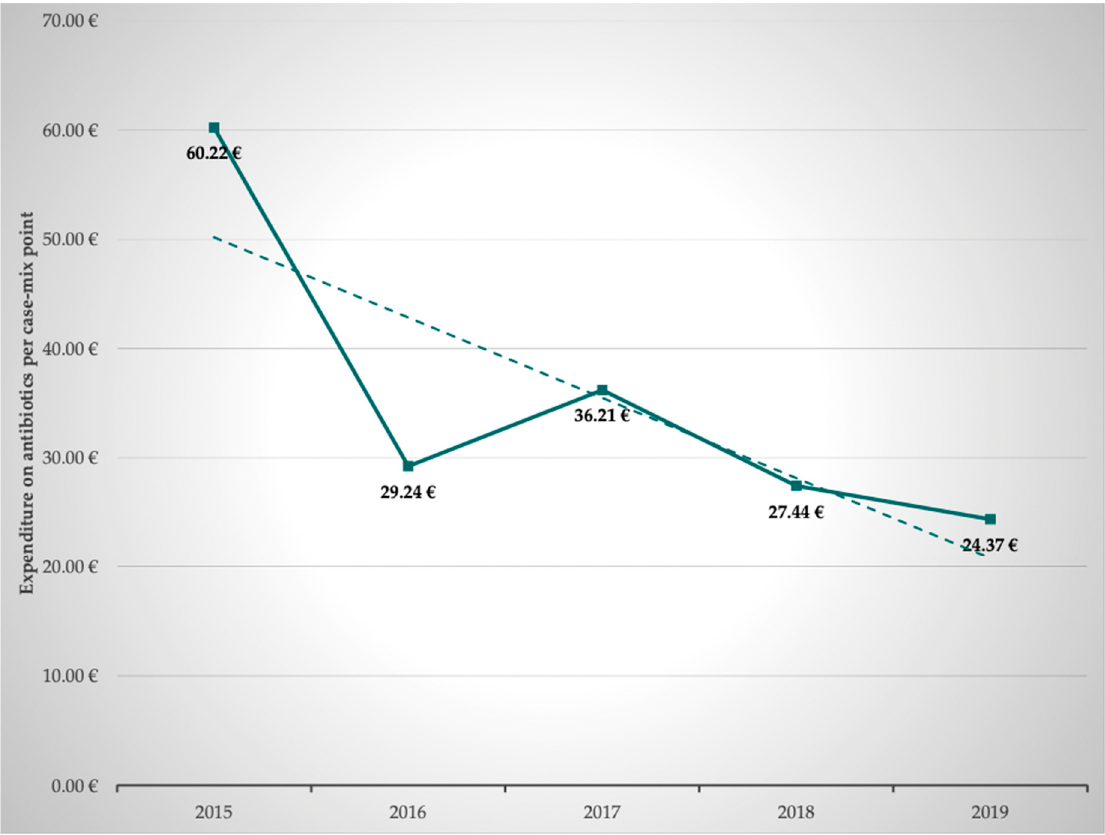
Figure 5. Expenditure on antibiotics per case mix point .